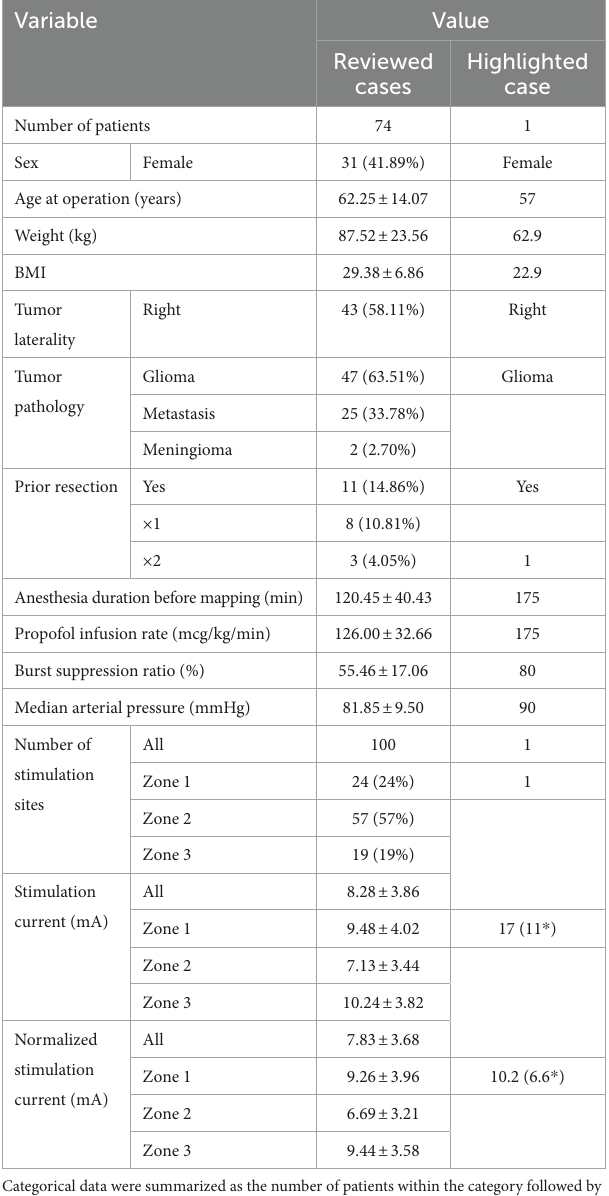
TABLE 1 Summarized variables between the highlighted case and other reviewed